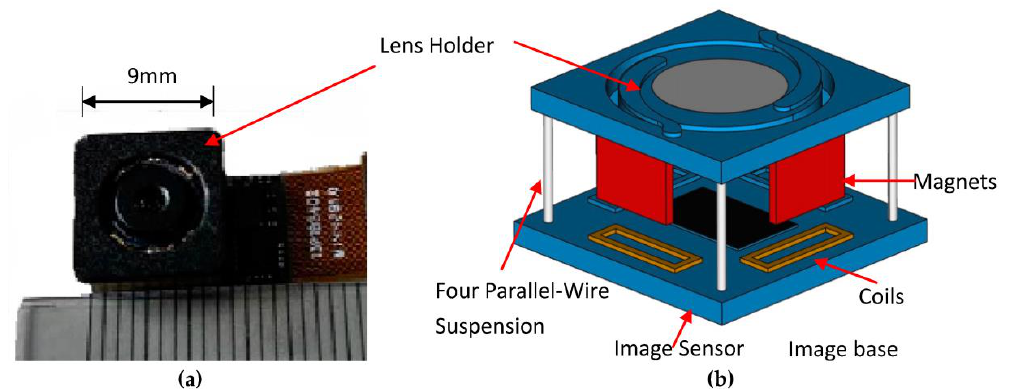
Figure 1. The designed optical image stabilizer (OIS) with 2 translational degrees-of-freedom (DOF), which includes an image base attached with an image sensor, magnets, four-wire suspension and a lens holder. ( a ) a photo; ( b ) a schematic of the OIS structure.